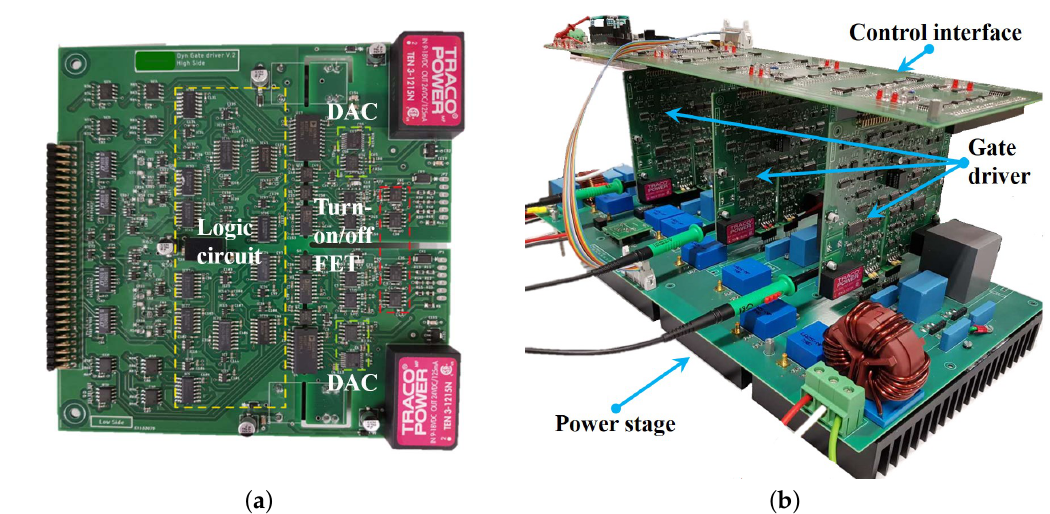
Figure 12. ( a ) Gate driver board and ( b ) Three-phase electric motor drive